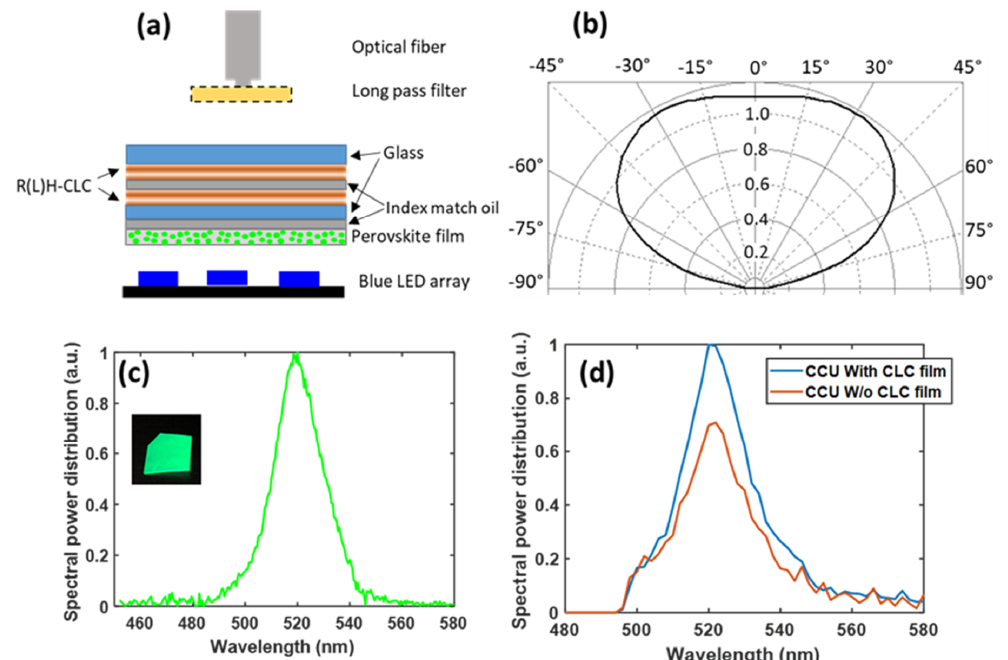
Figure 9. ( a ) Schematic diagram of the experimental setup. ( b ) Measured radiation pattern of the LED array. ( c ) Measured emission spectrum of the CsPbBr 3 perovskite film. Inset: CsPbBr 3 perovskite film under 365 nm UV light. ( d ) Measured emission spectrum of down-converted green light with and without the CLC film (filtered by the long pass filter with 500 nm cutoff wavelength).